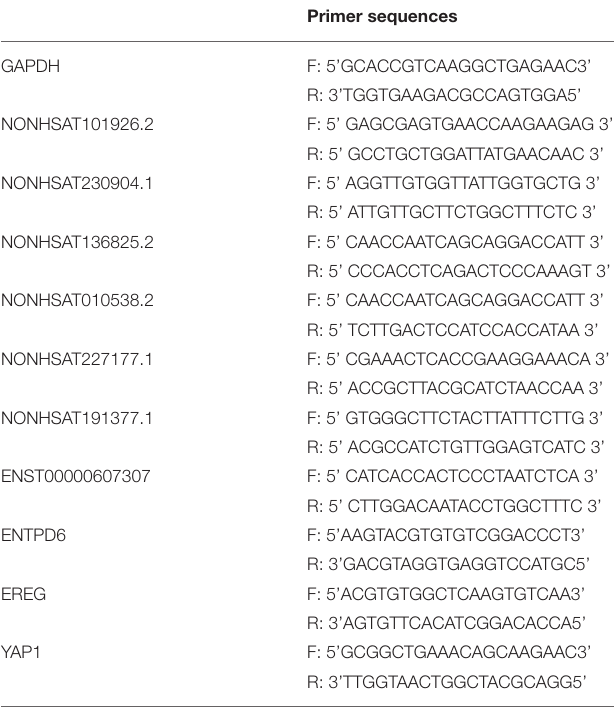
TABLE 3 | Primer sequences for